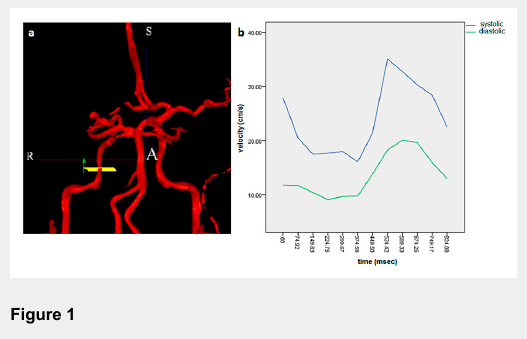
3D time-of-flight magnetic resonance angiography of the intracranial arteries with exactly perpendicular scan planes to vessel axis at target points, the green arrow indicates flow direction (a). Velocities were assessed 12 times each cardiac cycle (b).